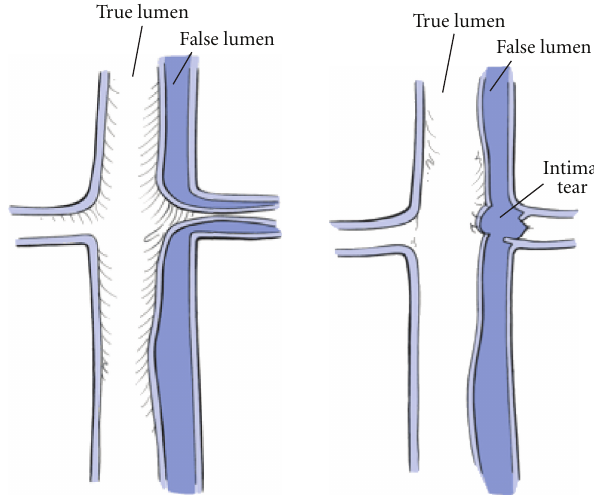
Figure 2: Malperfusion phenomena associated with acute type A dissection, (a) malperfusion is secondary to true lumen compres- sion by the false lumen and (b) occlusion of the branch vessel by extension of the false lumen. Reproduced with permission from Reece et al.